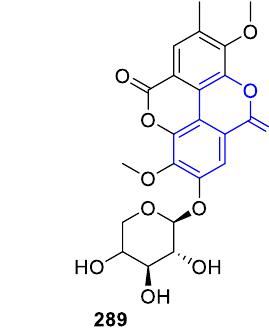
Figure 13. Chemical structures of coumarins isolated from the stem barks and leaves of Monotes kerstingii Gilg ( 287–289